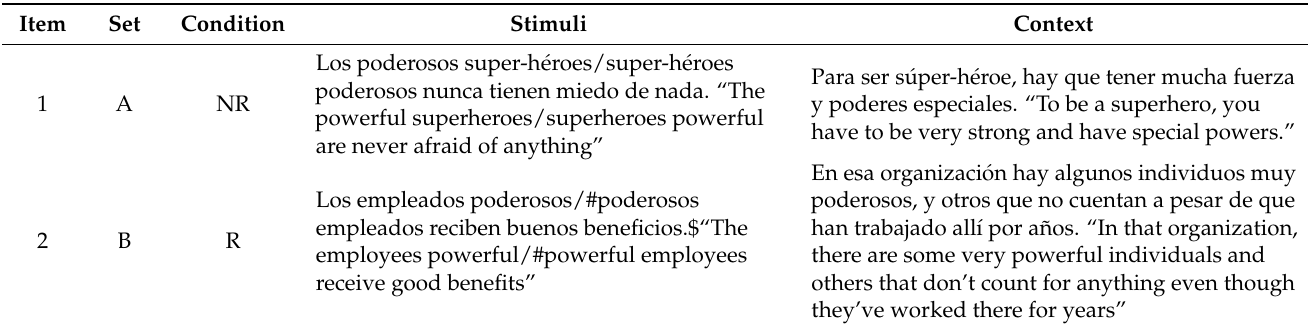
Table A1. Preference